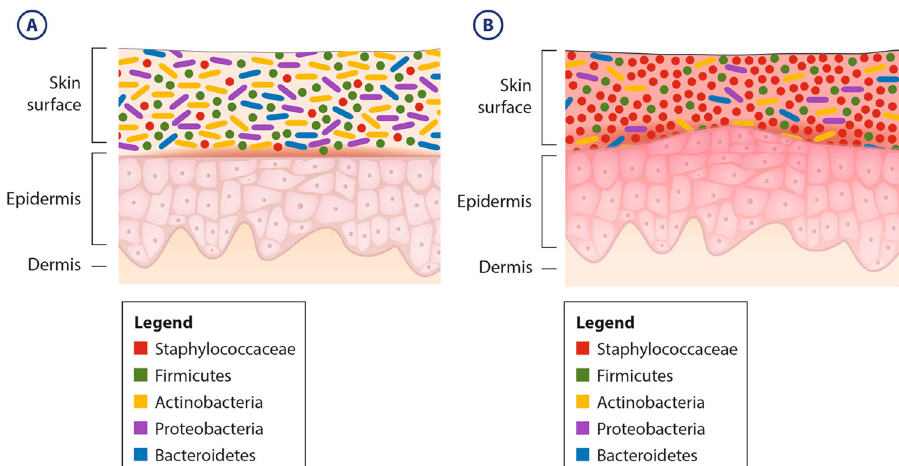
Fig. 1. AD fl ares are characterized by shifts in relative abundances of several bacterial species. a Abundance of the dominant skin bacterial phyla ( Firmicutes , Actinobacteria , Proteobacteria , and Bacteroidetes ) and the family Staphylococcaceae (a Firmicute ) associated with healthy skin. b AD induces dysbiosis characterized by a decrease in bacterial diversity and the dramatic increase in the proportion of Staphylococcaceae